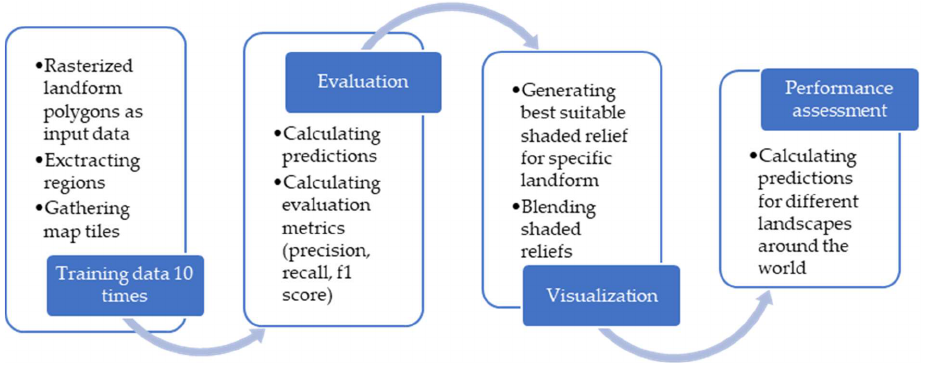
Figure 1. The workflow.